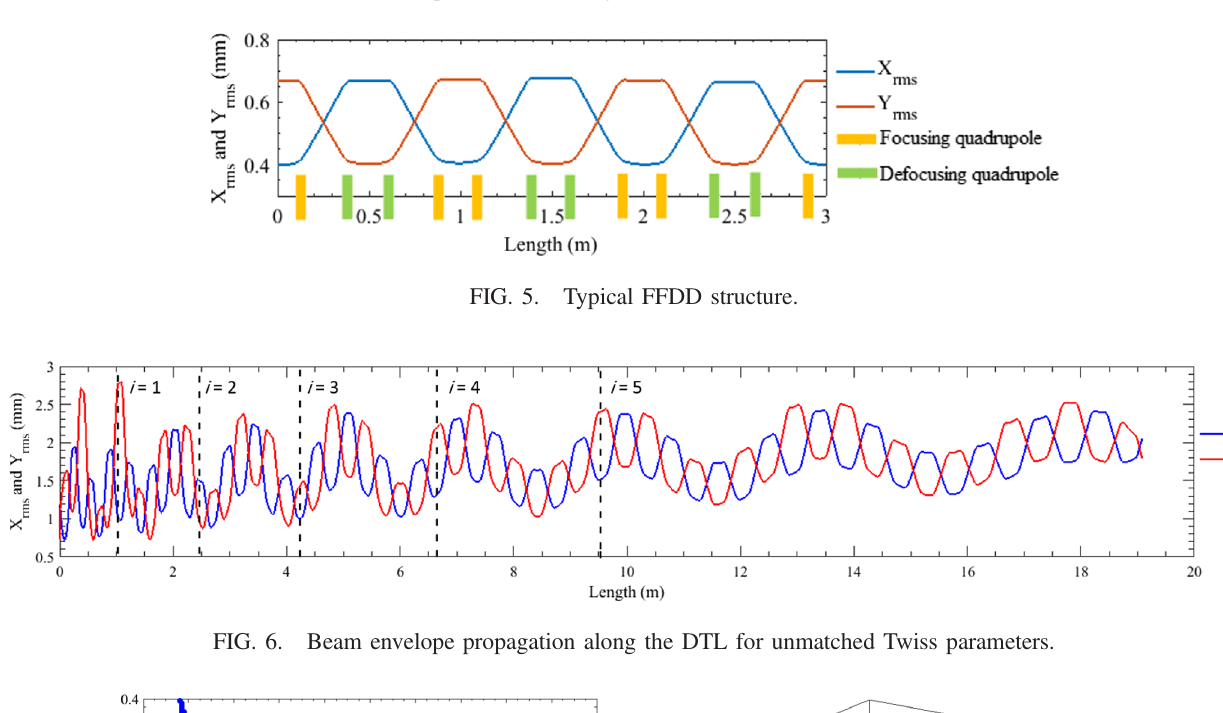
FIG. 4. Pareto optimal front of the LEBT NSGAII optimization and the TOPSIS selected point. Mismatching factor along the transverse x direction versus mismatching factor along the transverse y direction (left), and (right) the transmitted particles to RFQ entrance as a function of x and y transverse plane mismatching factors.